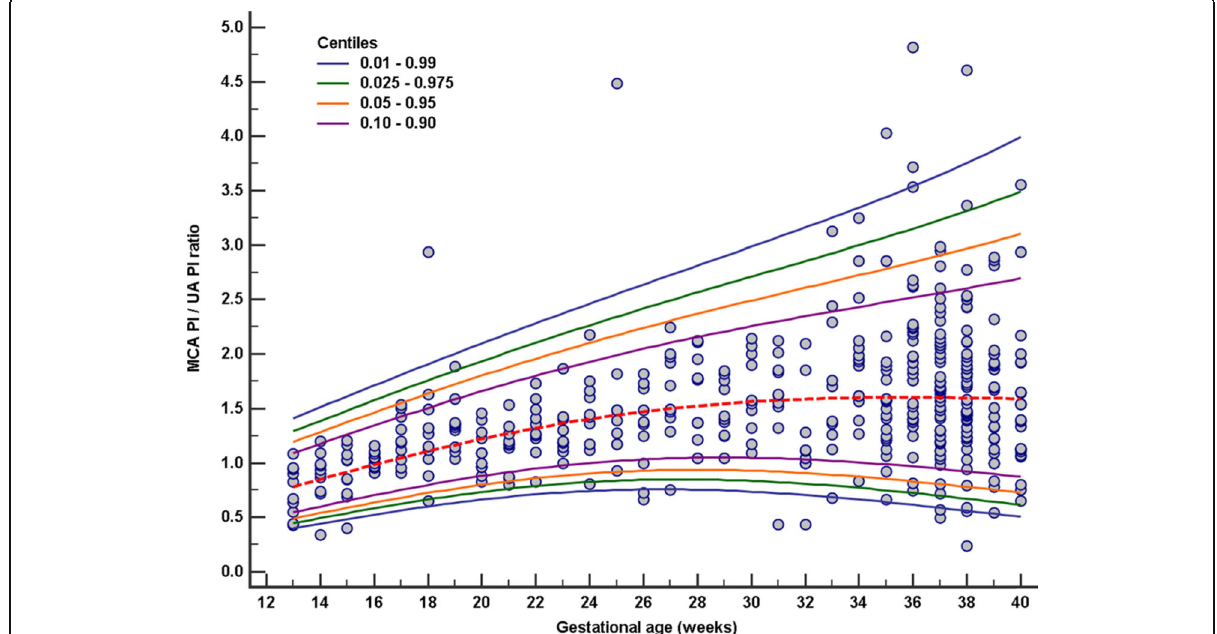
Fig. 4 PI MCA/UA. Scattered diagram of gestational age individual measurement and calculated reference ranges for MCA PI/UA PI in normal pregnancies (1284 observations) with 1st – 99th percentiles (blue lines) and 50th percentiles (red dashed